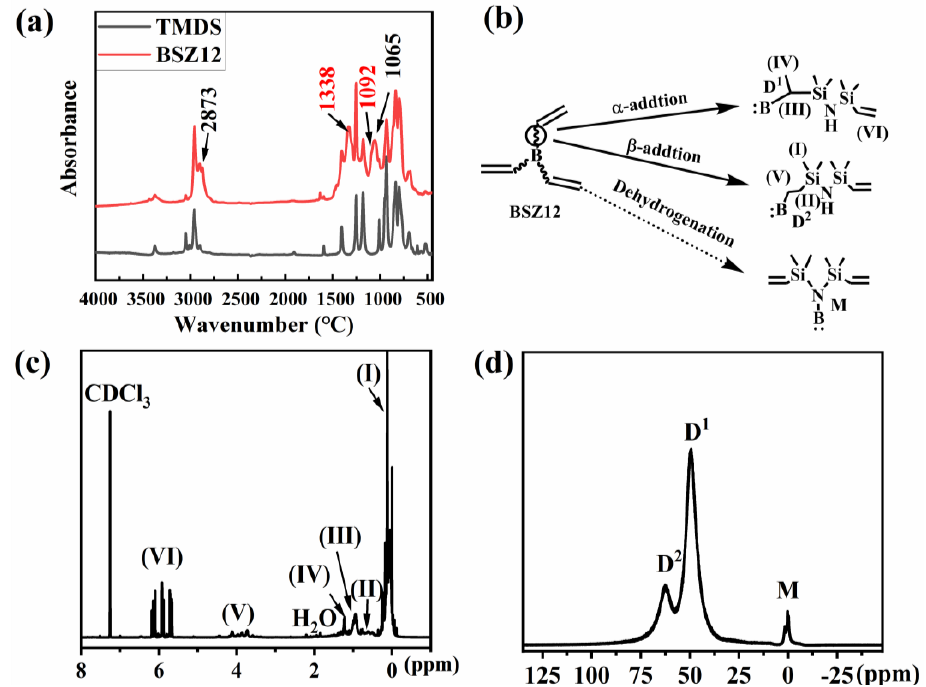
Figure 2. ( a ) Fourier transform infrared (FTIR) spectra of 1,1,3,3-tetramethyl-1,3-divinyldisilazane (TMDS) and BSZ12 monomers; ( b ) Structural composition of BSZ12 monomers; ( c ) 1 H NMR spectrum, and ( d ) 11 B NMR spectrum of BSZ12 monomers.